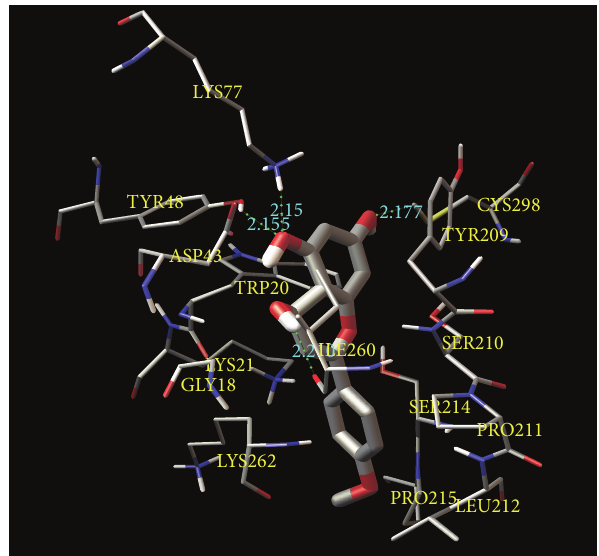
Figure 2: The promising docking pose of acacetin with ALR2. The amino acid residues (in 1 ˚A distance) were represented in atom types and the hydrogen bonds were denoted in green spheres along with the